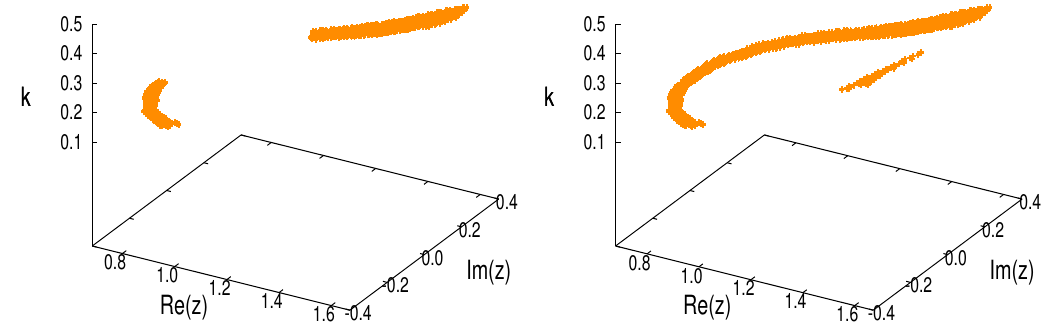
Figure 9 . The parameter space constrained by 3 (cid:27) oscillation data as well as the requirement of positive baryon asymmetry. Left panel: Y B estimated without pure N 2 contribution. Right panel: Y B is calculated taking into account this pure N 2 contribution.